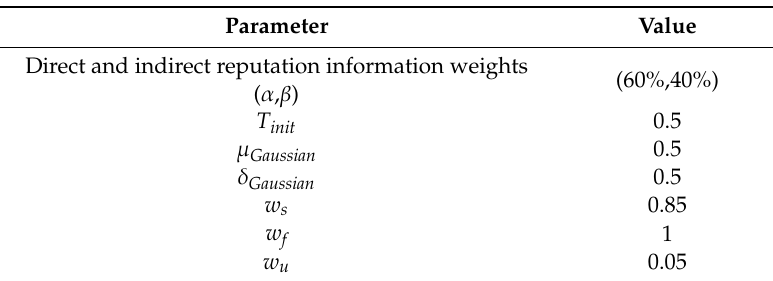
Table 1. Simulation parameter table.